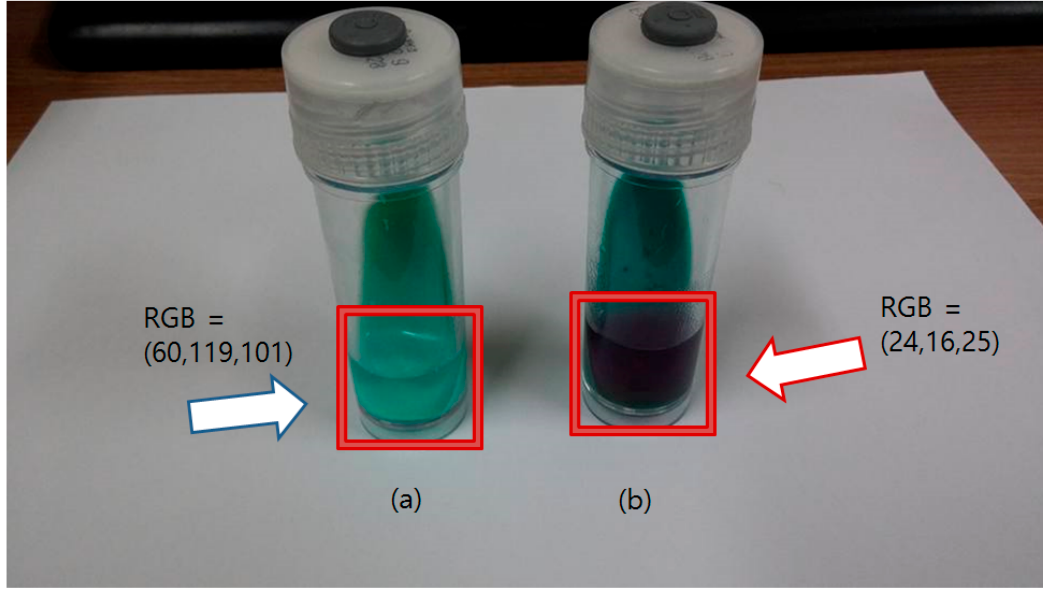
Figure 5. Result of the Nitrate Reductase Assay using API Nitrite Kit based detecting solution. ( a ) The bottle at the left side is the blank sample (nothing cultured), which shows the detecting solution remains clear and unchanged (blue arrow); ( b ) The bottle with the positive control is at the right side, showing a purple solution (red arrow). The RGB values indicate the average RGB values of the liquid region.